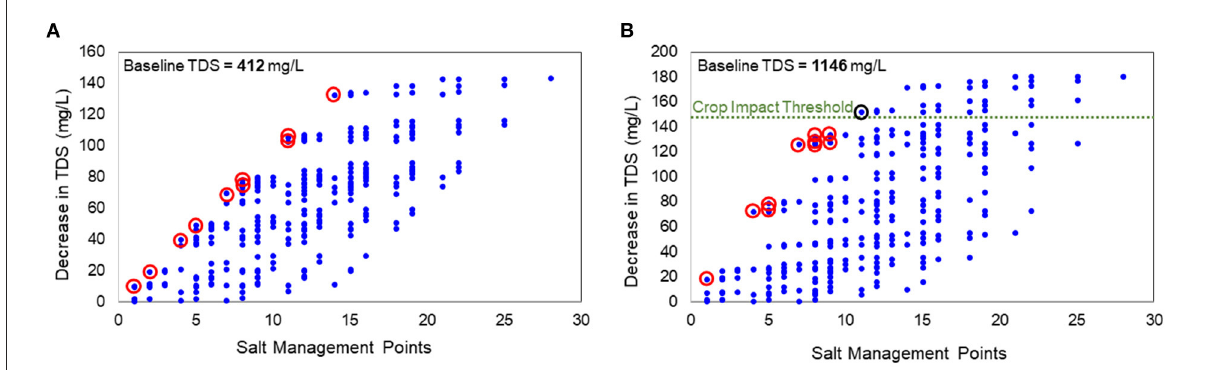
FIGURE11 Results of the salt management strategies for (A) the urban areas and the (B) agricultural areas, for the months April–October. Each blue dot represents a unique strategy, with the red circles indicating the 10 most efficient strategies, based on the ratio of the decrease in TDS from the baseline value to salt management points. In (B) , the crop impact threshold, which corresponds to an in-river concentration of 1,000 mg/L (146 decrease from the 1,146 mg/L baseline value), is shown in a green dotted line. The black circle indicates the most efficient salt management strategy that meets the crop impact threshold of 1,000 mg/L.